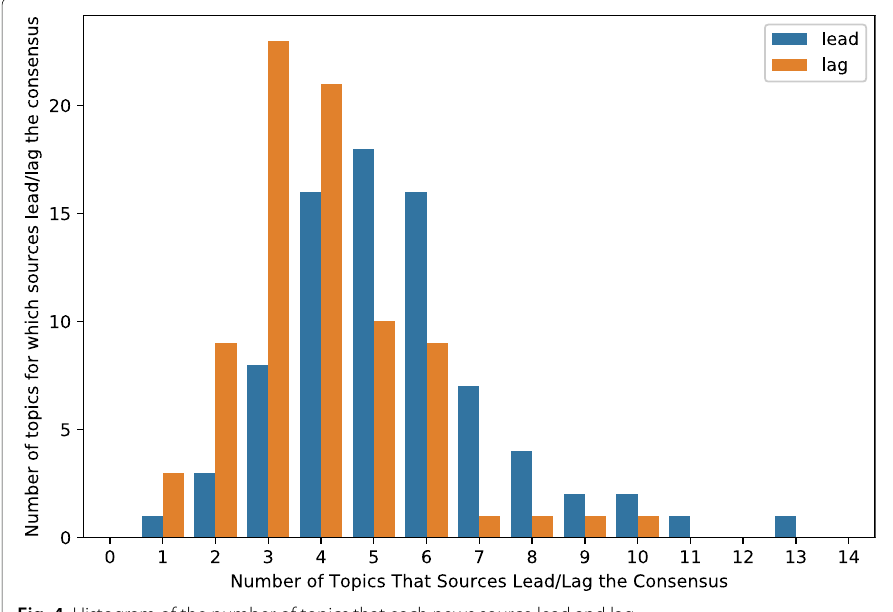
Fig. 4 Histogram of the number of topics that each news source lead and lag